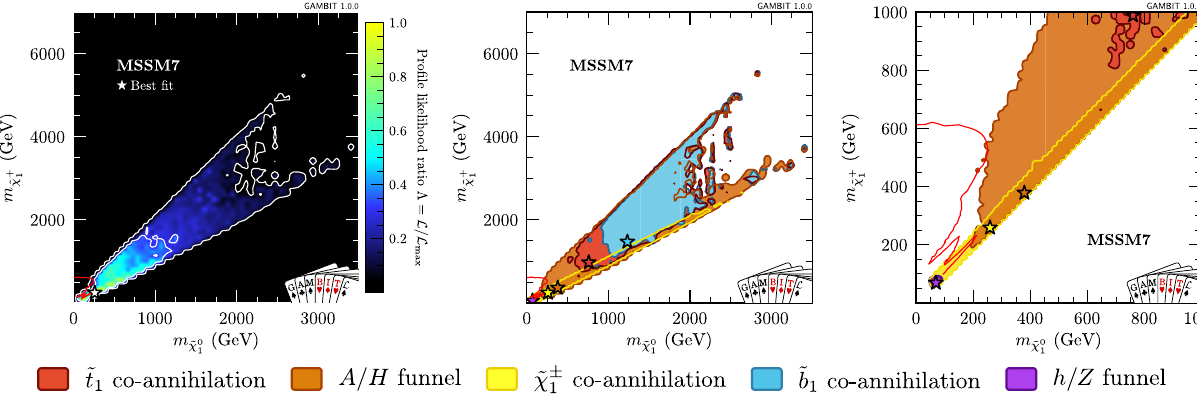
− ˜ χ 0 Fig. 8 Left: profile likelihood in the ˜ χ ± mass plane. Centre: sub- tons [229]. This limit should be interpreted with caution (see main text 1 1 regions within the 95% CL profile likelihood region, coloured accord- for details). Right: the same information as the central plot, but zoomed ing to mechanisms by which the relic density constraint is satisfied. The into the low-mass region. Note that, although the CMS limit appears regions shown correspond to neutralino co-annihilation with charginos, to have excluded part of the chargino co-annihilation region, this is a stops or sbottoms, and resonant annihilation through the light or heavy binning effect. One should instead refer to the plot of the ˜ χ ± Higgs funnels. Superimposed in red is the latest CMS Run II simpli- mass difference in Fig. 7, which provides finer resolution on the mass ˜ χ 0 fied model limit for ˜ χ ± difference in this region production and decay with decoupled slep- 1 1